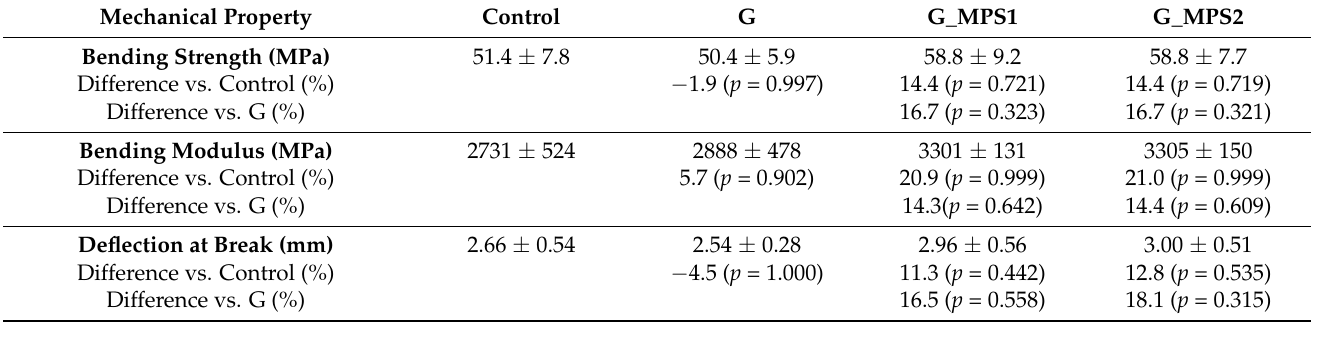
Table 1. Bending properties and cycles to fatigue failure (mean ± SD) for control and bone cements with 0.1 wt.% of graphene (G) and silanised G obtained from G_Oxi1 (G_MPS1) and from G_Oxi2 (G_MPS2). The difference of each value compared with control and with G of each cement is given in %.